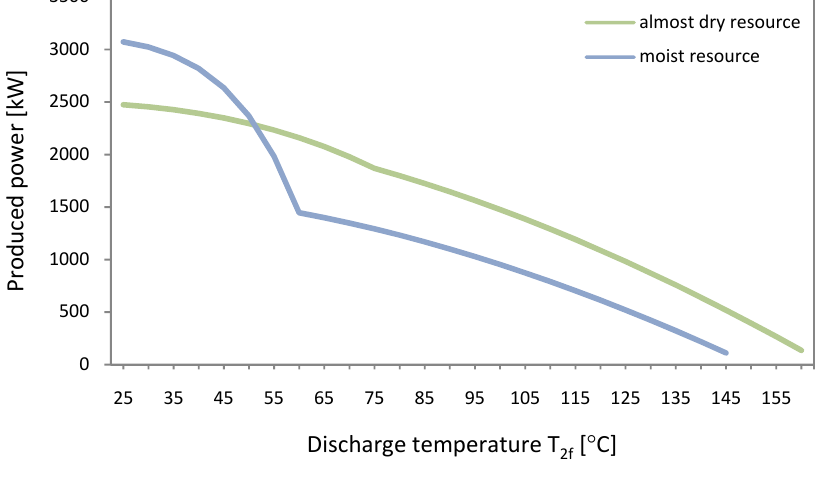
Figure 2. Produced power calculated for 50% cycle exergy